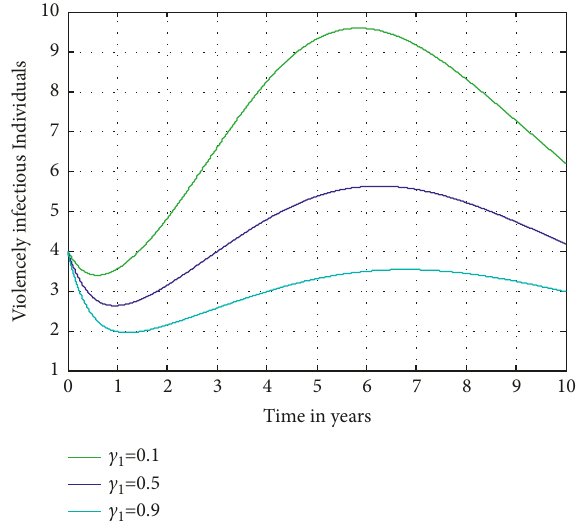
Figure 8: Effect of the negotiation rate c fectious individuals P